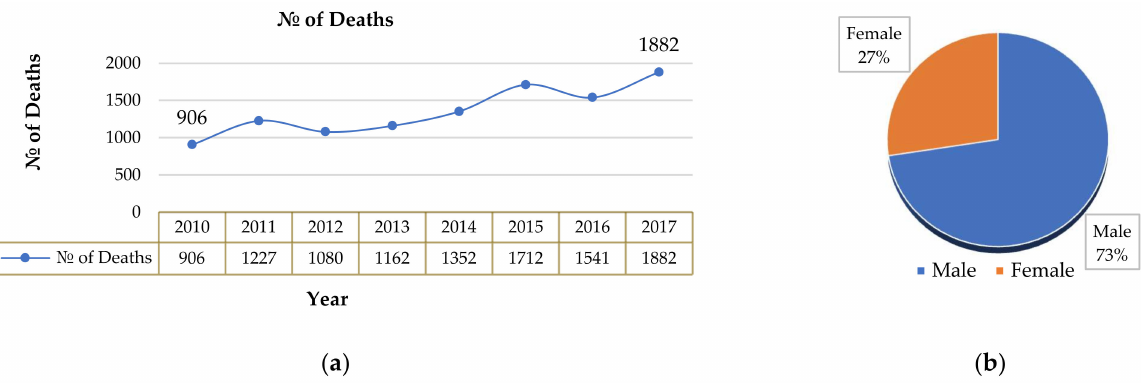
Figure 5. ( a ) Total lives lost due to RTCs; ( b ) Percentage deaths (Female versus Male).